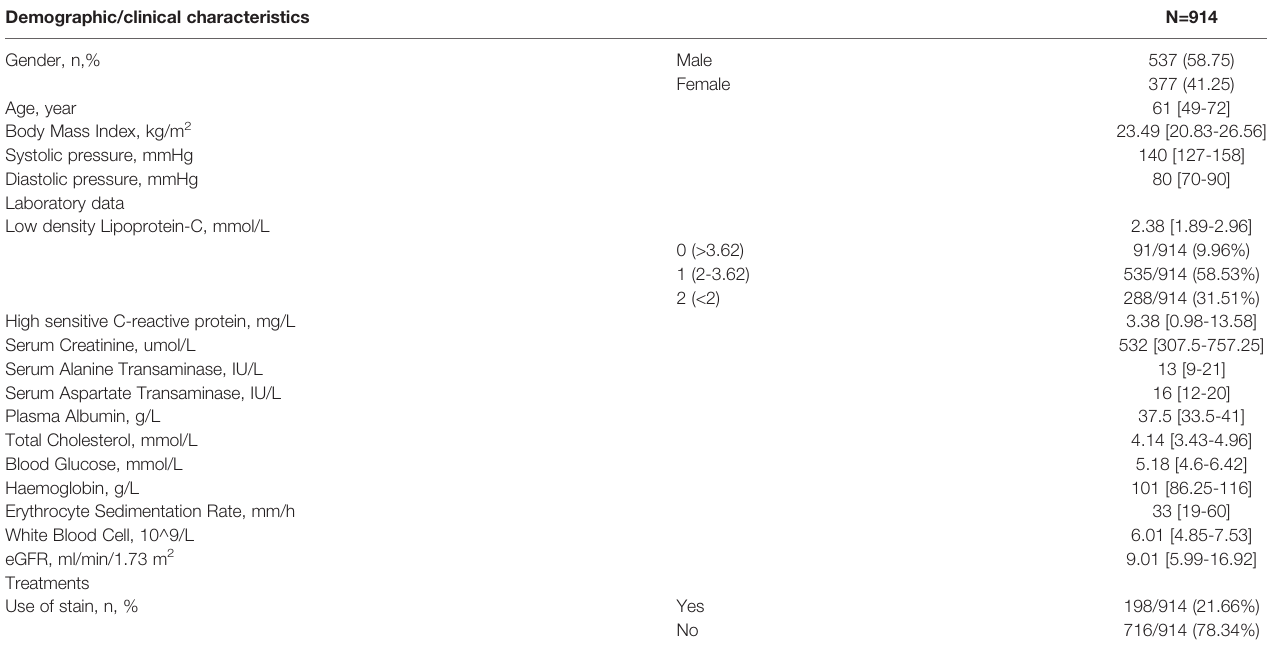
TABLE 1 | Clinical characteristics of patients in predicting model of LDL. Demographic/clinical characteristics